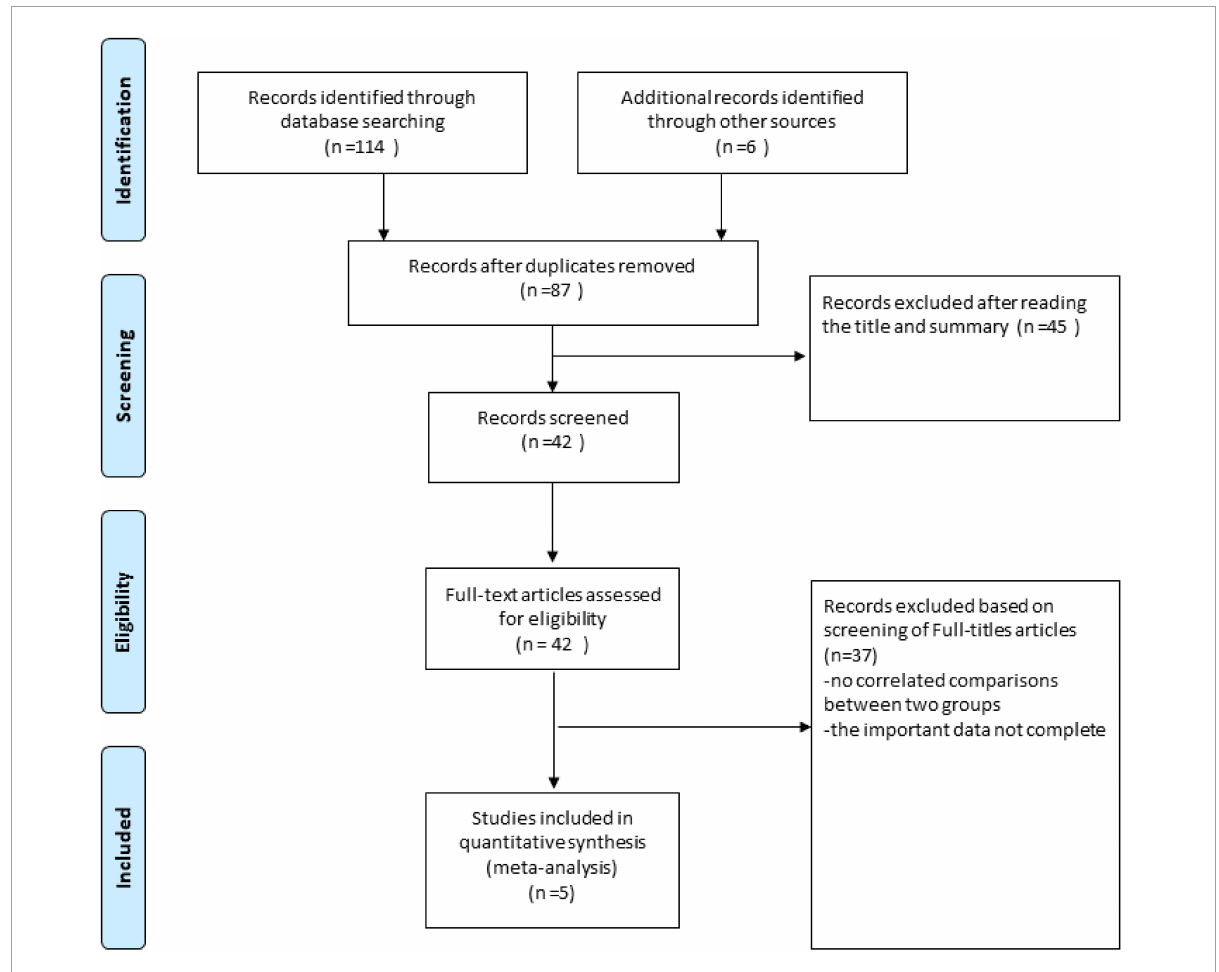
FIGURE1 Flow diagram of the search strategy for systematic review and meta-analysis.